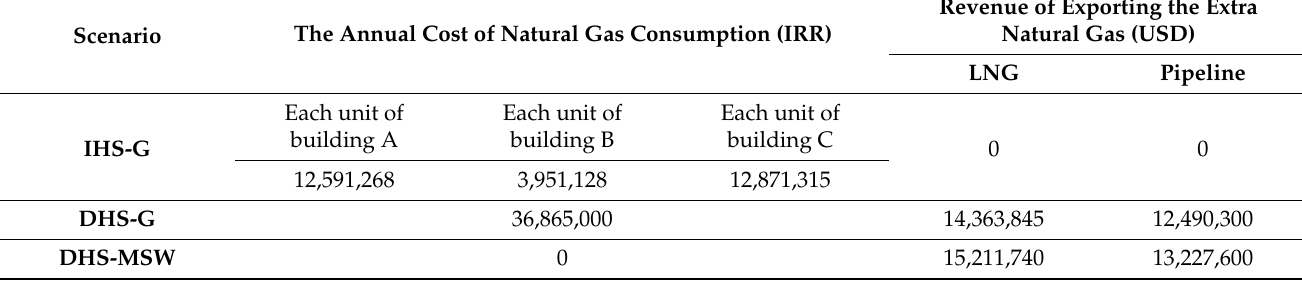
Figure 13. The comparison of GHG emission and greenhouse effect of the three scenarios. Table 19. The annual cost of natural gas and the revenue of exporting the extra